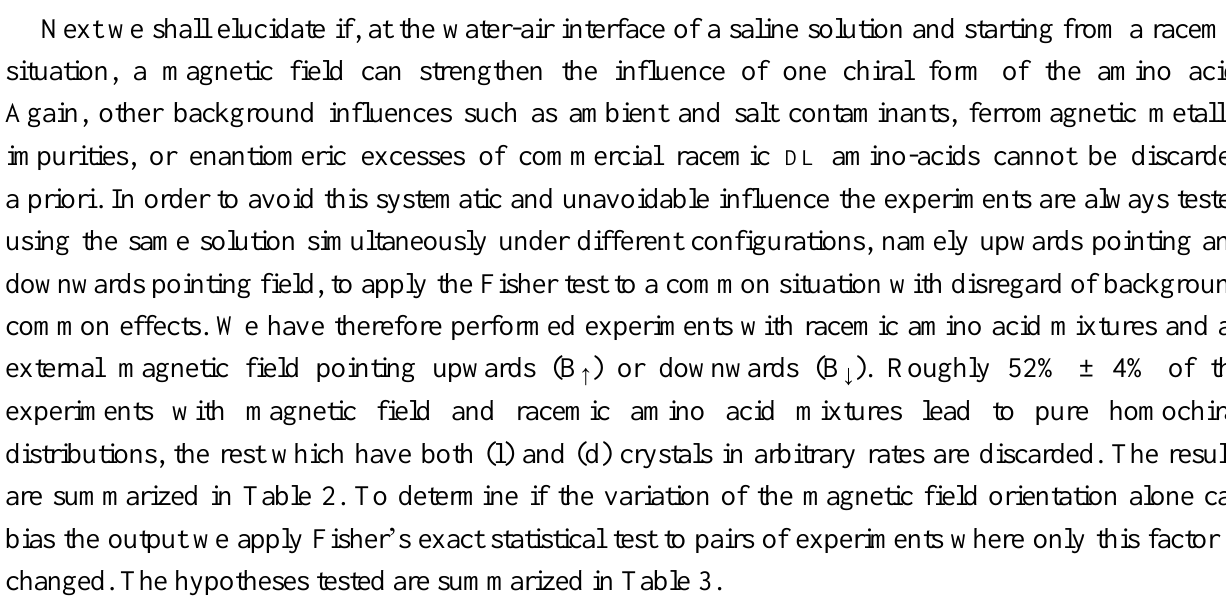
or downwards B pointing ↑ ↓ with racemic mixtures of 3